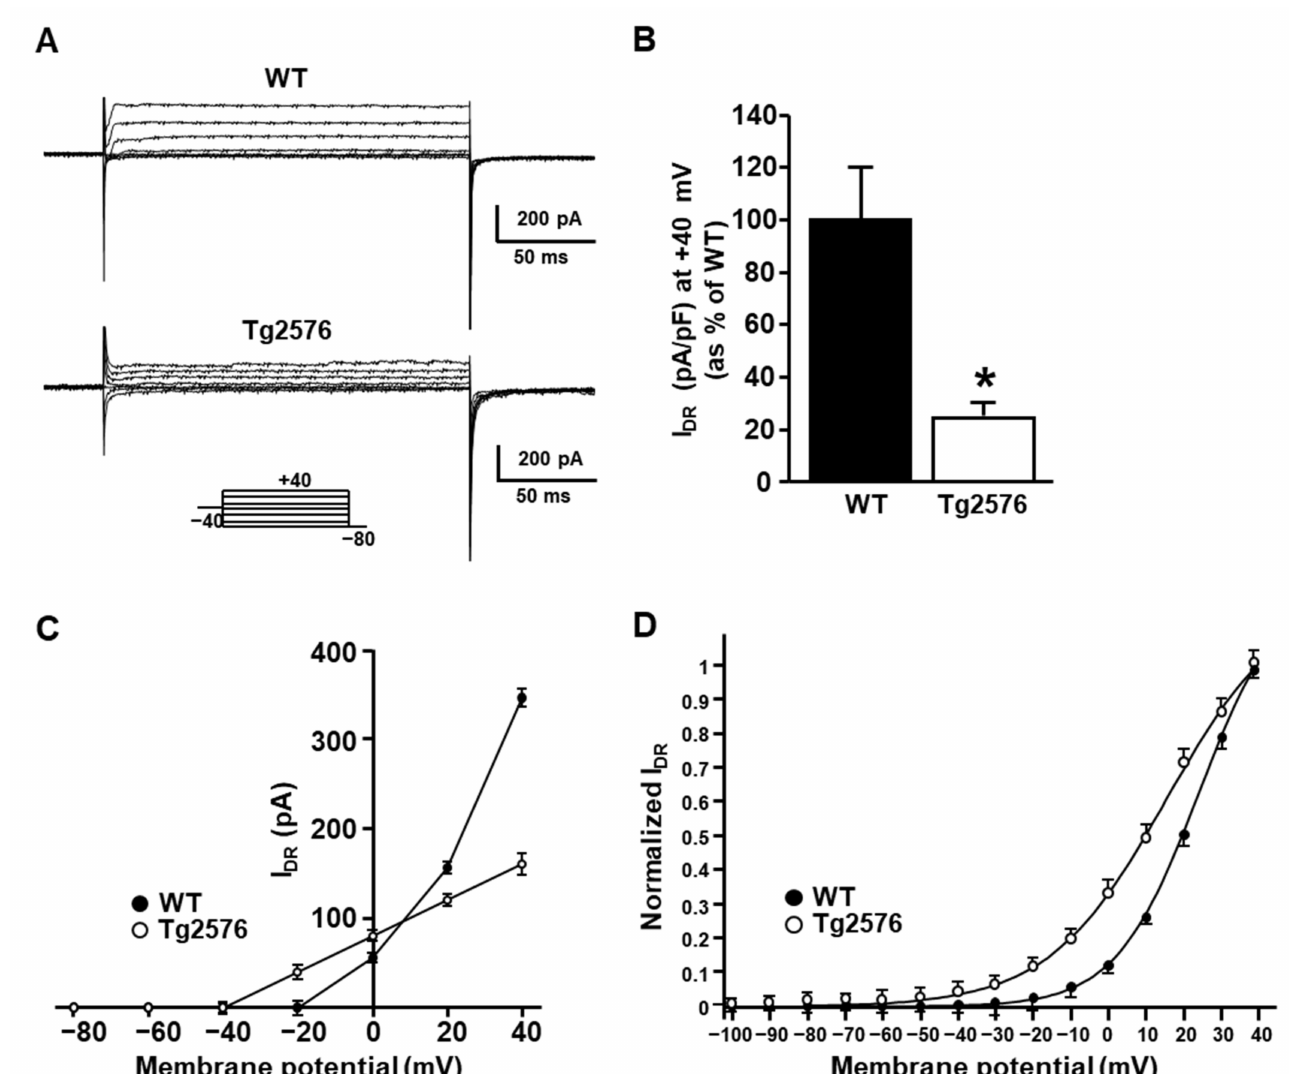
Figure 2. Delayed rectifier K + currents in Tg2576 primary hippocampal pyramidal neurons. ( A ) Rep- resentative traces of I DR recorded in the WT ( top ) and Tg2576 ( bottom ) primary hippocampal pyramidal neurons at 12 DIV using the voltage protocol shown in the lower part of the panel. ( B ) Quantification of I DR densities represented in panel A . The peak value I DR was measured at the end of the +40 mV depolarizing pulse. Values are expressed as mean ± SEM of 3 independent experimental sessions. * p < 0.001 vs. WT. ( C ) Current-voltage (I/V) relationships for the I DR recorded in the WT and Tg2576 hippocampal neurons. Values are expressed as mean ± SEM of 3 independent experimental sessions. ( D ) Steady-state activation properties of I DR recorded in WT and Tg2576 primary hippocampal neurons. Values are expressed as mean ± SEM of 3 independent experimental sessions. * p < 0.001 vs.